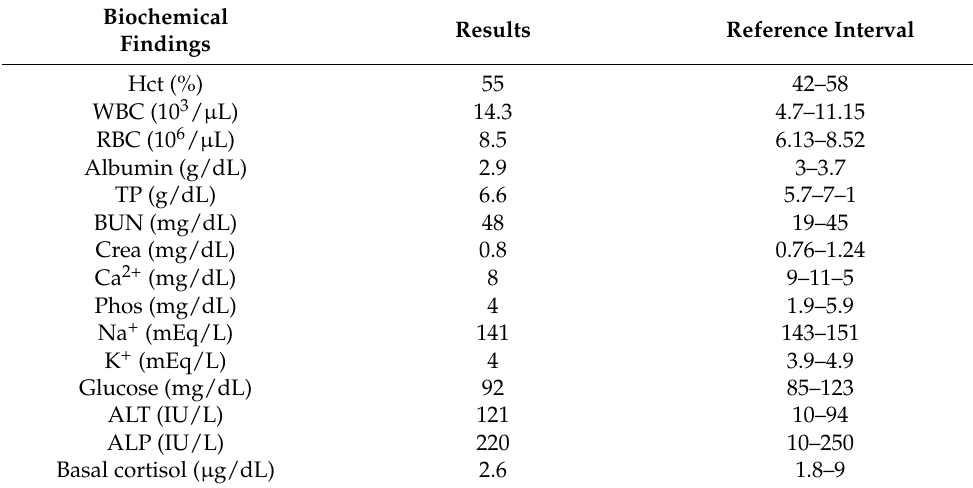
Table 2. Main biochemical findings recorded during diagnostic workup.